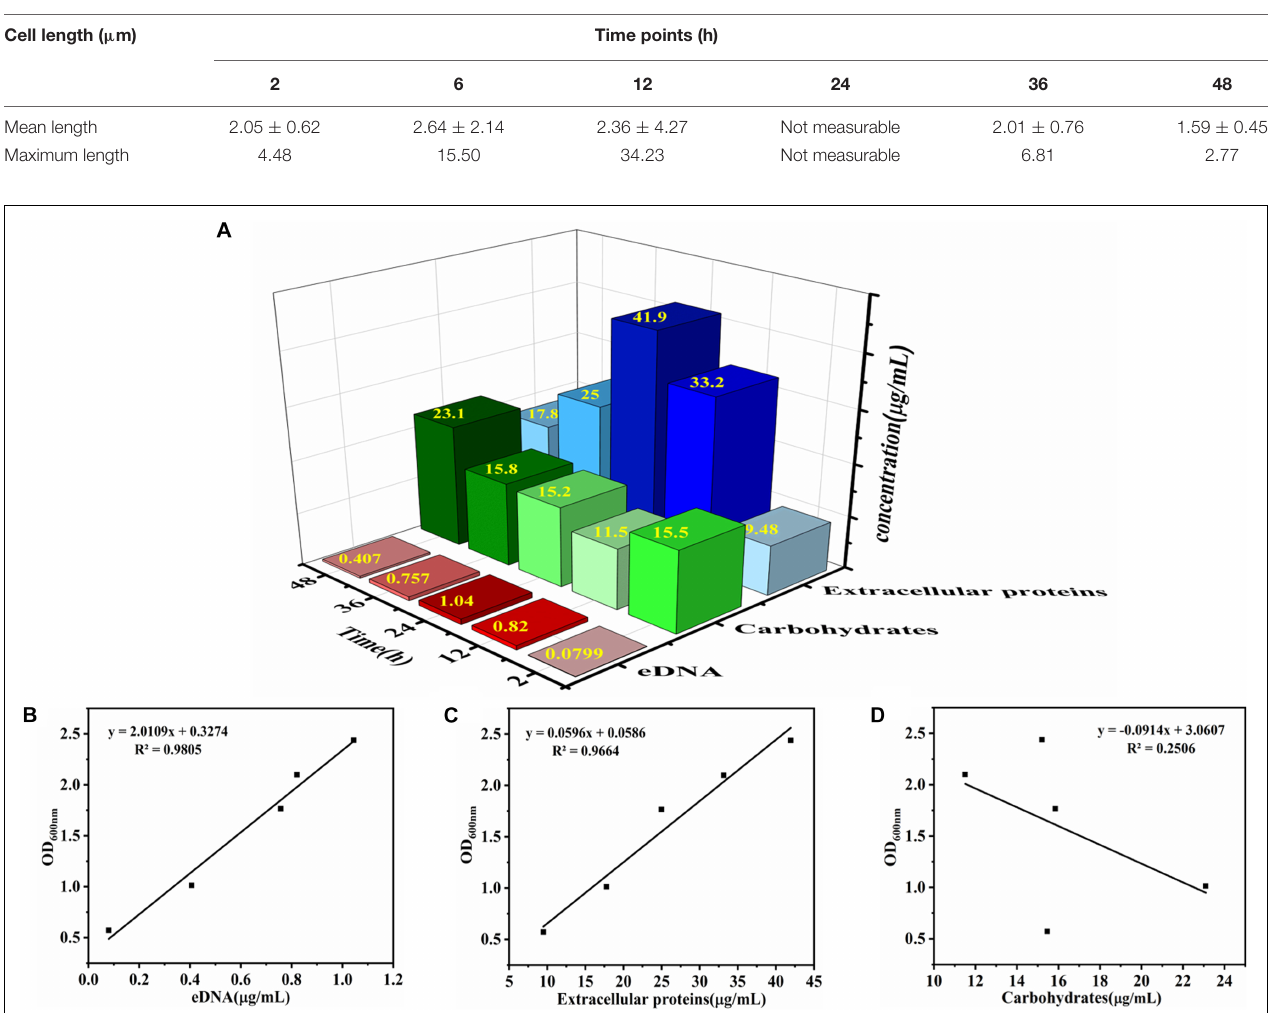
TABLE 2 | Quantification of the length of biofilm cells of V. parahaemolyticus after 2, 6, 12, 24, 36, and 48 h of incubation.